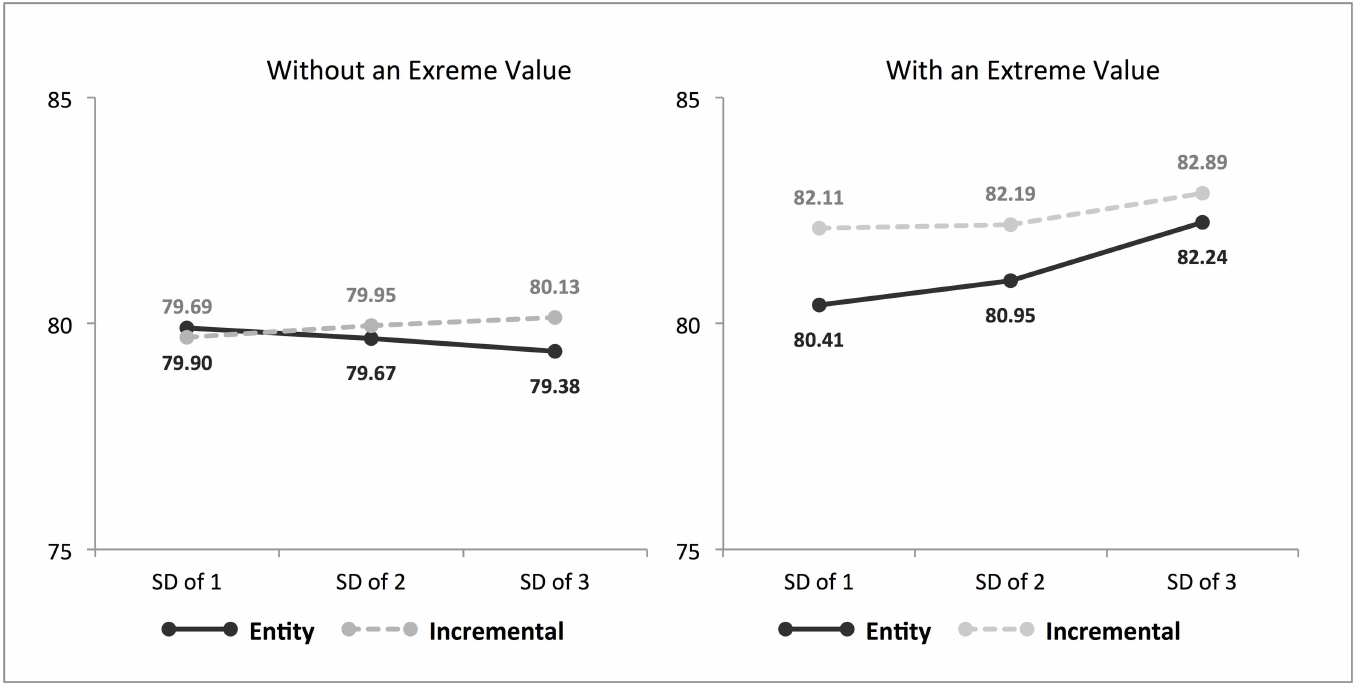
Fig 2. Study 3 –Estimated Average of the